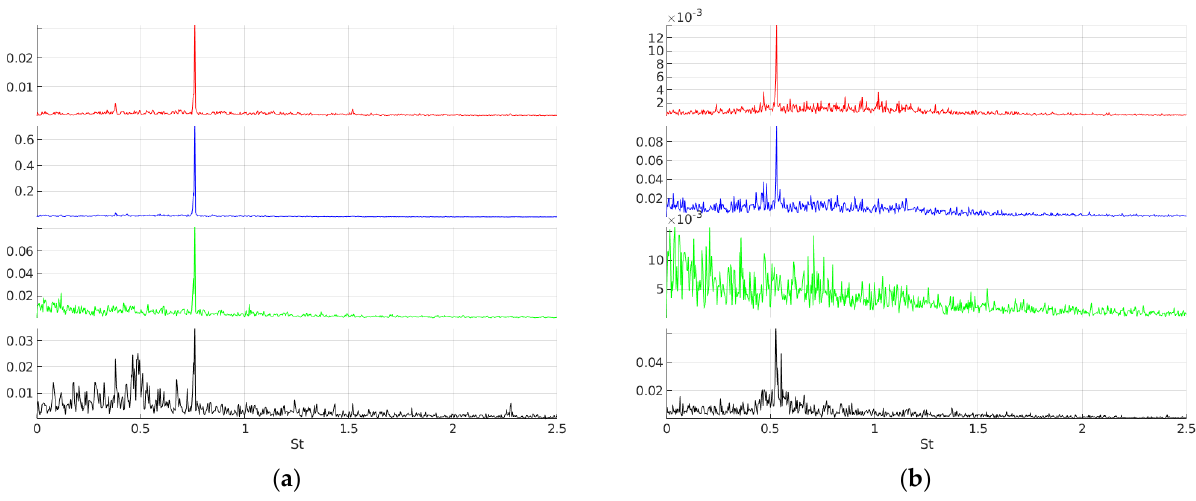
Figure 27. PSD plots of streamwise velocity recorded at 𝑥 𝐷⁄ = 1. 6 for ( a ) case ‘0-0’ and ( b ) ‘0-60’. Red: lower half, 𝑦 = 0 , 𝑧 = −0.035 m ; Blue: centre, 𝑦 = 0 , 𝑧 = 0 ; Green: upper half, 𝑦 = 0 , 𝑧 = 0.035 m ; Black: left side, 𝑦 = 0.035 m , 𝑧 = 0 .